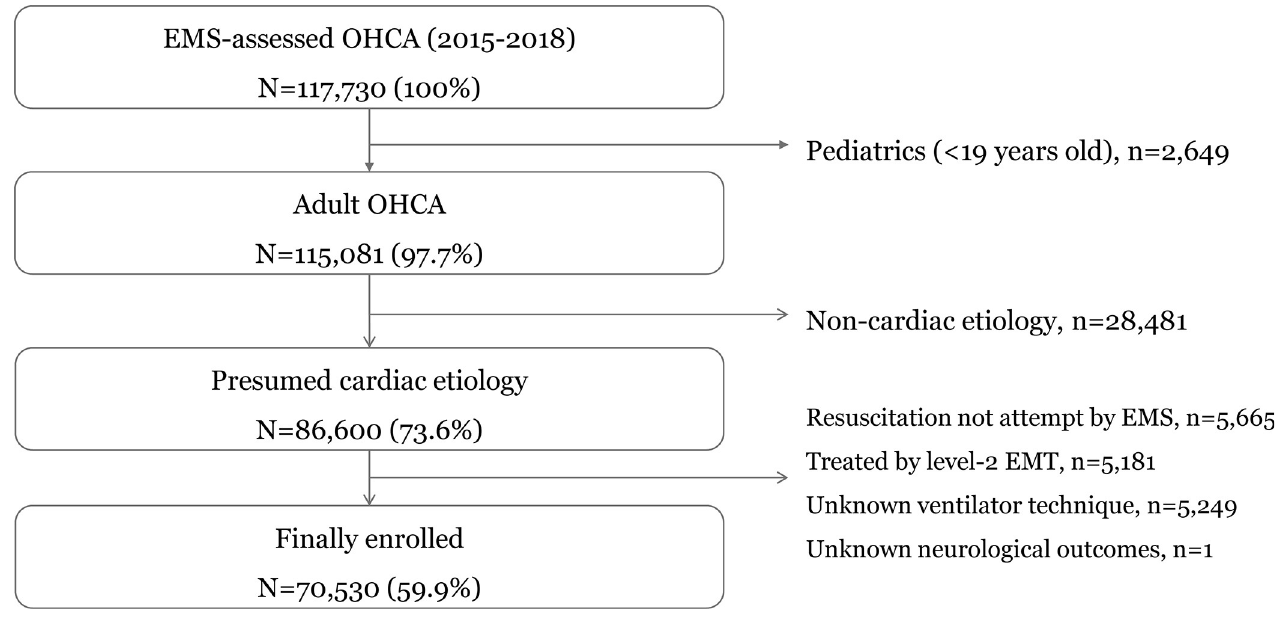
Fig 1. Study populations of observational